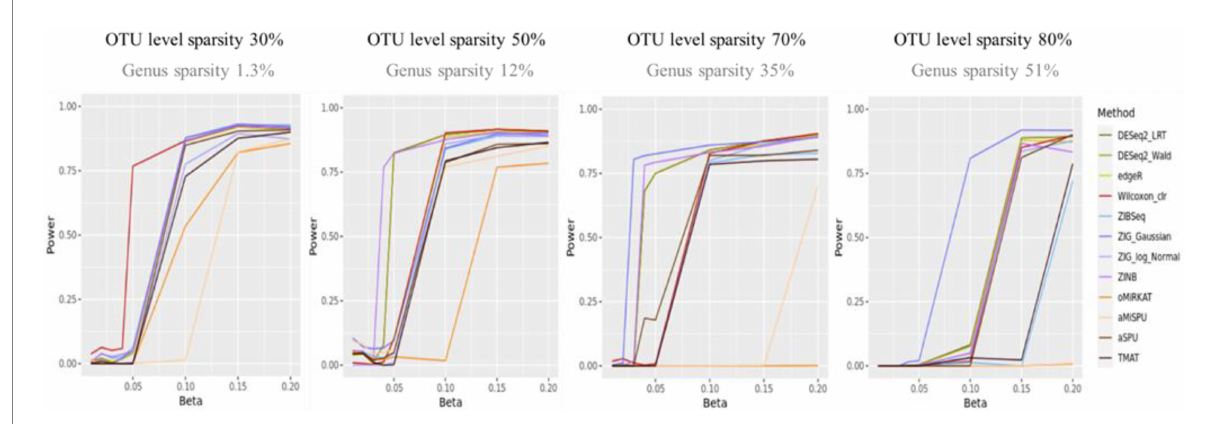
FIGURE 2 The statistical power of the individual methods. The x -axis represents the degree of association ( β ). The value of s β were given as